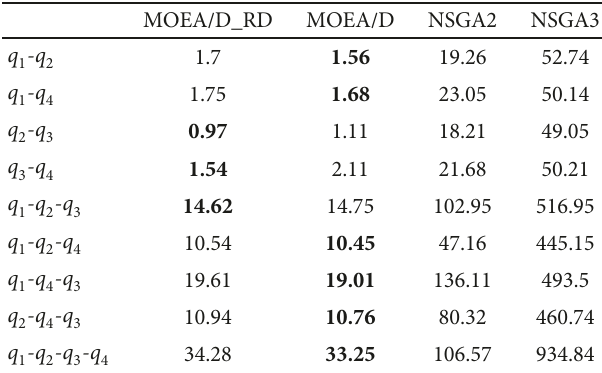
Table 11: Average running time of the four compared algorithms.